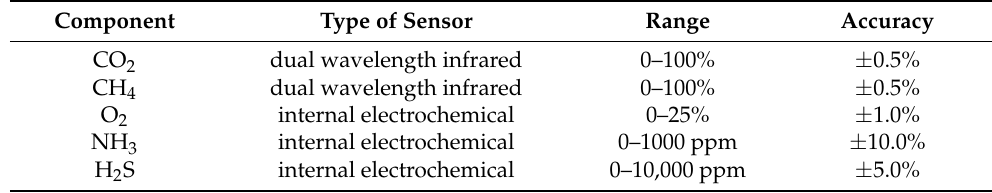
Table 3. Technical specification of the BIOGAS 5000 gas analyzer.